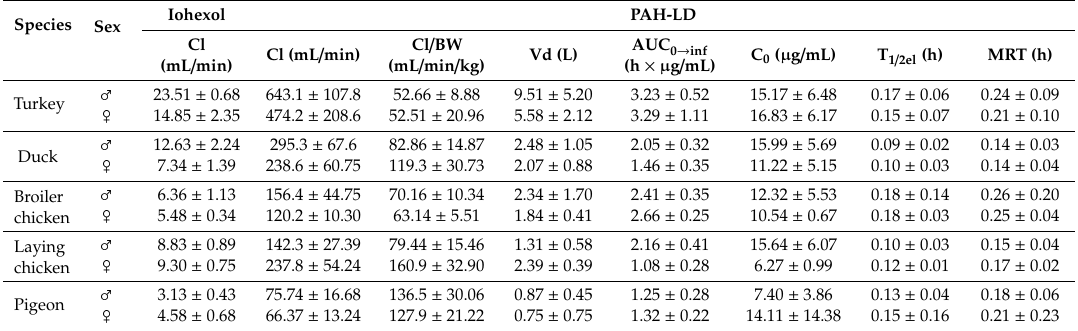
Table 1. Main pharmacokinetic parameters of para-aminohippuric acid and iohexol clearance following the IV administration of 10 mg para-aminohippuric acid and 64.7 mg iohexol / kg bodyweight (BW) to di ff erent poultry species. Values ( n = 8) are presented as mean ± SD.